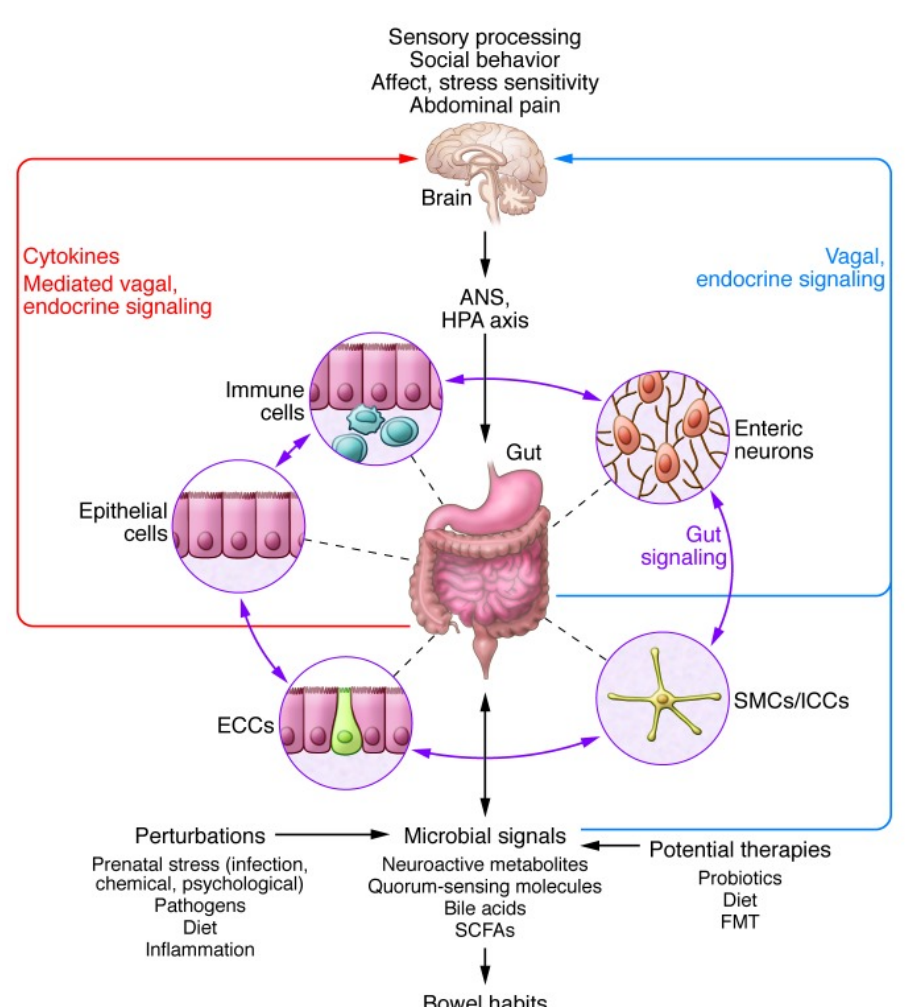
Figure 2. Bidirectional interactions within the gut microbiota/brain axis [126]. A network of special- ized target/transducer cells in the gut wall functions as an interface between the microbiota and the host lumen. In response to external and bodily demands, the brain modulates these specialized cells within this network via the branches of the ANS (sympathetic and parasympathetic/vagal efferents) and the HPA axis. Such modulation can be transient, such as in response to transient perturbations, or long lasting such as in response to chronically altered brain output. The microbiota are in constant bidirectional communication with this interface via multiple microbial signaling pathways, and this communication is modulated in response to perturbations of the microbiota or the brain. The integrated output of the gut microbial–brain interface is transmitted back to the brain via multiple afferent signaling pathways including the endocrine (metabolites, cytokines, and microbial signaling molecules) and neurocrine (vagal and spinal afferents). While acute alterations in this interoceptive feedback can result in transient functional brain changes (GI infections), chronic alterations are associated with neuroplastic brain changes. Potential therapies aim to normalize altered microbiota signaling to the ENS and central nervous system. ECC, enterochromaffin cells; FMT, fecal microbial transplant; ICC, interstitial cell of Cajal; SCFA, short-chain fatty acid; SMC, smooth muscle cell. Vagal and dorsal root ganglion afferents innervating the gut express TLRs and re- ceptors for inflammatory cytokines, such as IL-1 β and tumor necrosis factor (TNF)- α , and relay inflammatory and immune signals to the CNS. Vagal afferents relay these signals to the nucleus of the solitary tract (NTS) and dorsal root ganglion afferents to lamina I of the spinal cord. Upon activation, sensory afferents may regulate local vascular and immune responses through antidromic signaling mediated by the release of substance